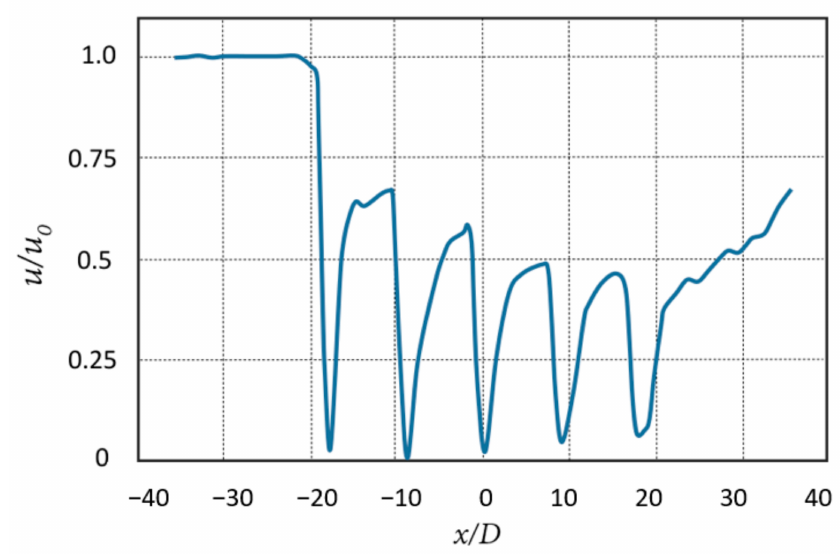
Figure 4. Normalized stream-wise wind velocity along the wind turbine array at hub